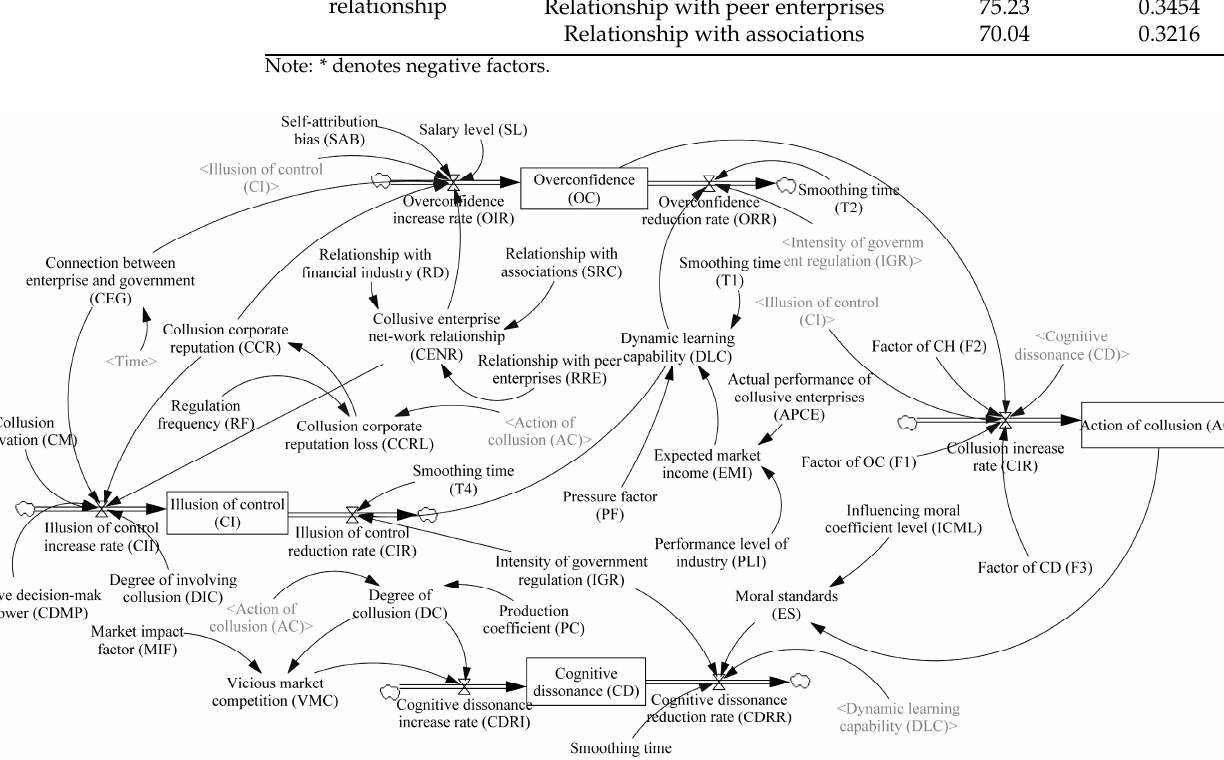
Table 4. Main items of the proposed model. Items